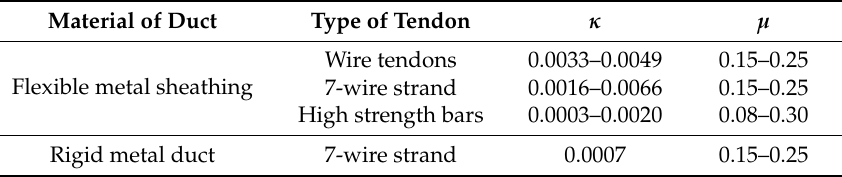
Table 2. Suggested value of κ and µ in ACI code.